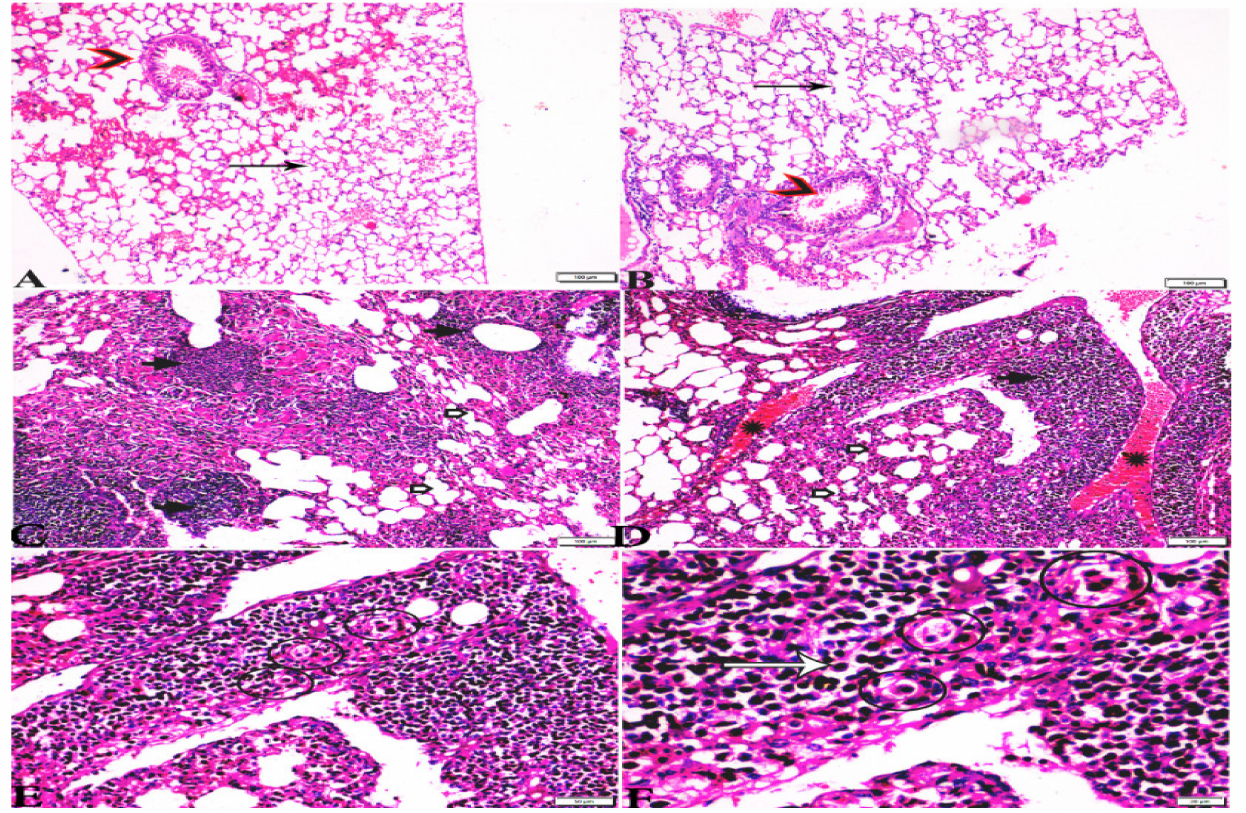
Figure 7. Photomicrograph of H&E-stained lung tissue sections from mice in the experimental groups: ( A , B ): lung tissue sections from the negative control group (G1) showing: normal bronchiolar structure (arrow heads), normal alveolar tissue (arrows). ( C – F ): Lung tissue sections from the T. gondii - infected positive group (G2): ( C , D ): collapsed alveoli (white arrows), multiple focal lymphoid hyperplasia (black arrows), and severe vascular congestion (stars). ( E , F ): Multiple tissue cysts containing bradyzoites (circles) and multiple diffuse bradyzoites (arrows). The scale bar is provided below each